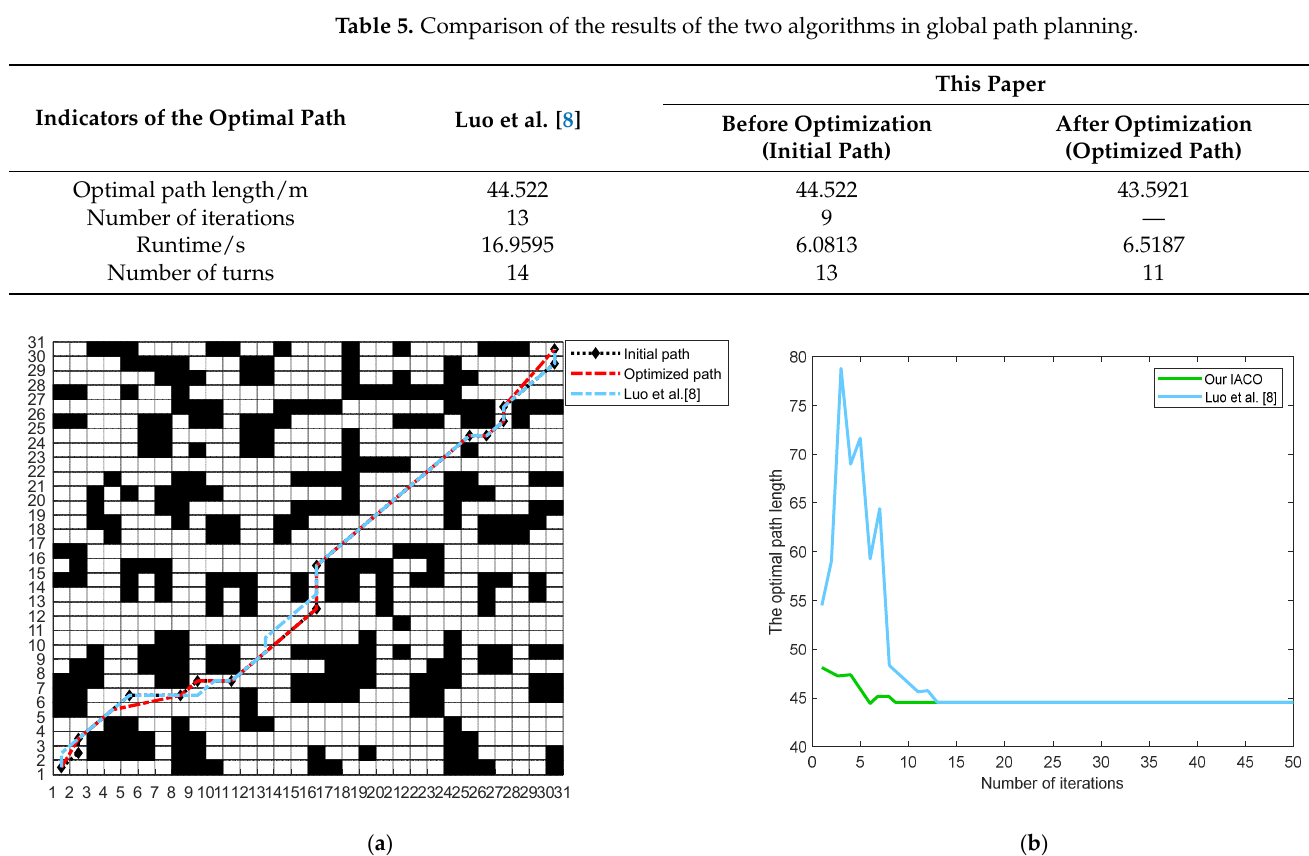
Figure 13. Comparison experiment 2. ( a ) Path planning. ( b ) Convergence curve. Table 5. Comparison of the results of the two algorithms in global path planning.